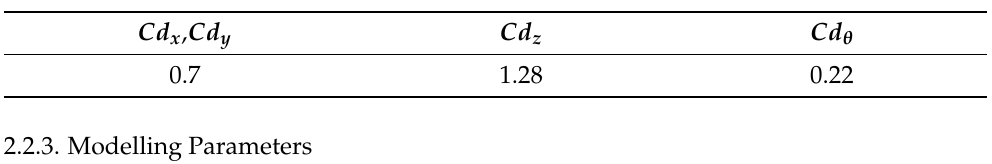
Table 1. Drag coefficients adapted from